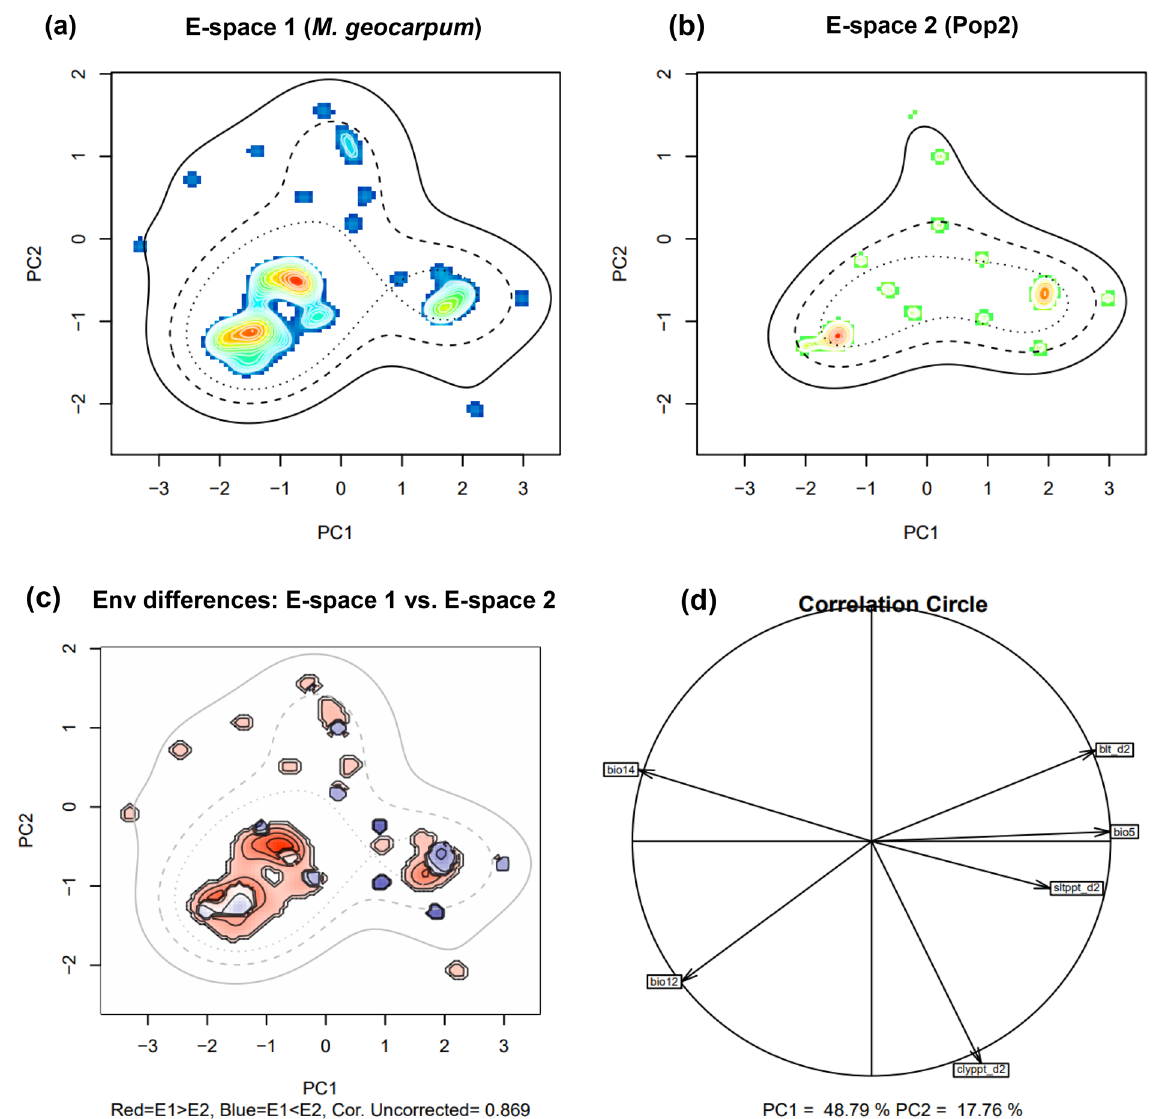
Figure 5. Niches of the two compared groups ( M. geocarpum and genetic Pop2) in two dimensional E-space. Graphs ( a ) and ( b ) represent the niches of species and Pop2, respectively along the first two axes of the PCA. The occurrences are represented by kernel density isopleths, red colour indicates high density and blue colour indicates low density. Solid and dotted contour lines illustrate 100% and 50% of the available background (environmental space). ( c ): is the diference in the E-space of the two groups, and Niche E-space Correlation Index (NECI). NECI determines if one should correct the occurrence densities of each group by the prevalence of their environments in their range for equivalency and background tests. For high NECI (> 0.5) groups occupied niches are recommended to be corrected by the frequency of E-space in accessible environments to reduce the chances of committing type 1 errors, and ( d ) is the correlation circle based on the two principal components of the environmental input data. bio5 max temperature warmest month, bio12 mean annual rainfall, bio14 rainfall driest month, blt_d2 bulk density in kg/cubic-meter for 10 cm depth, clyppt_d2 soil texture fraction clay at 10 cm depth, Sltppt_d2 soil texture fraction silt in percent for 10 cm